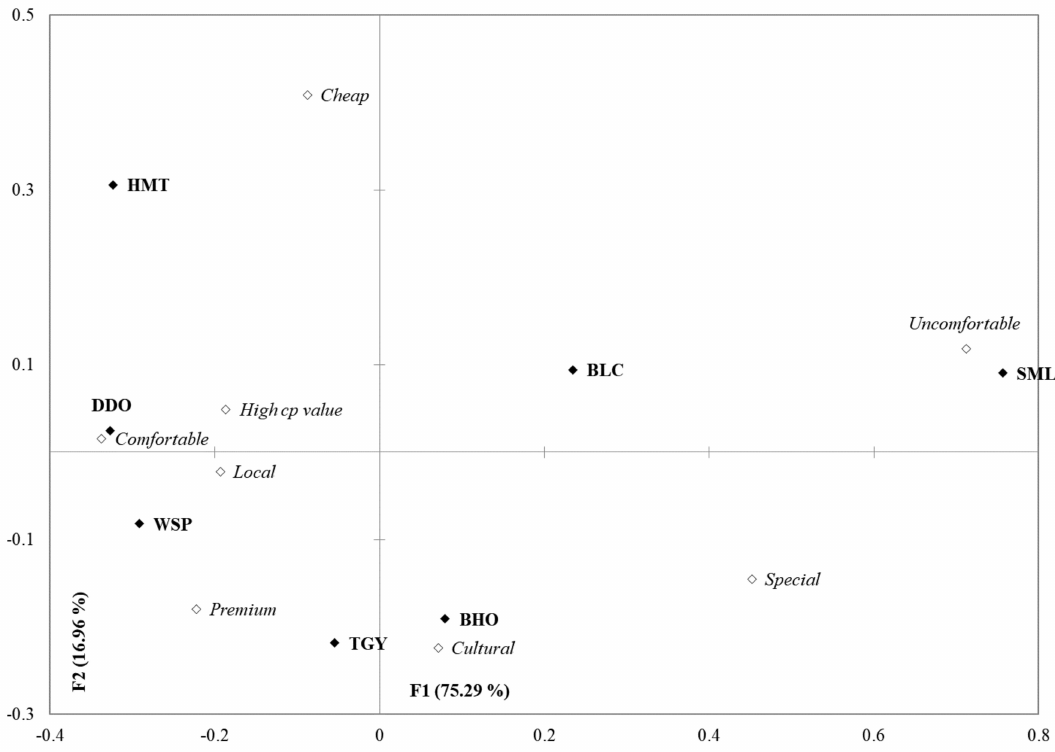
Figure 2. A bi-plot by correspondence analysis of the 7 tea infusions in association with the 8 association attributes selected by more than 20% of participants. BLC: Bi-Luo-Chun green tea, WSP: Wenshan Pouchong tea, HMT: High-mountain oolong tea, DDO: Dong Ding oolong tea, TGY: Iron Goddess